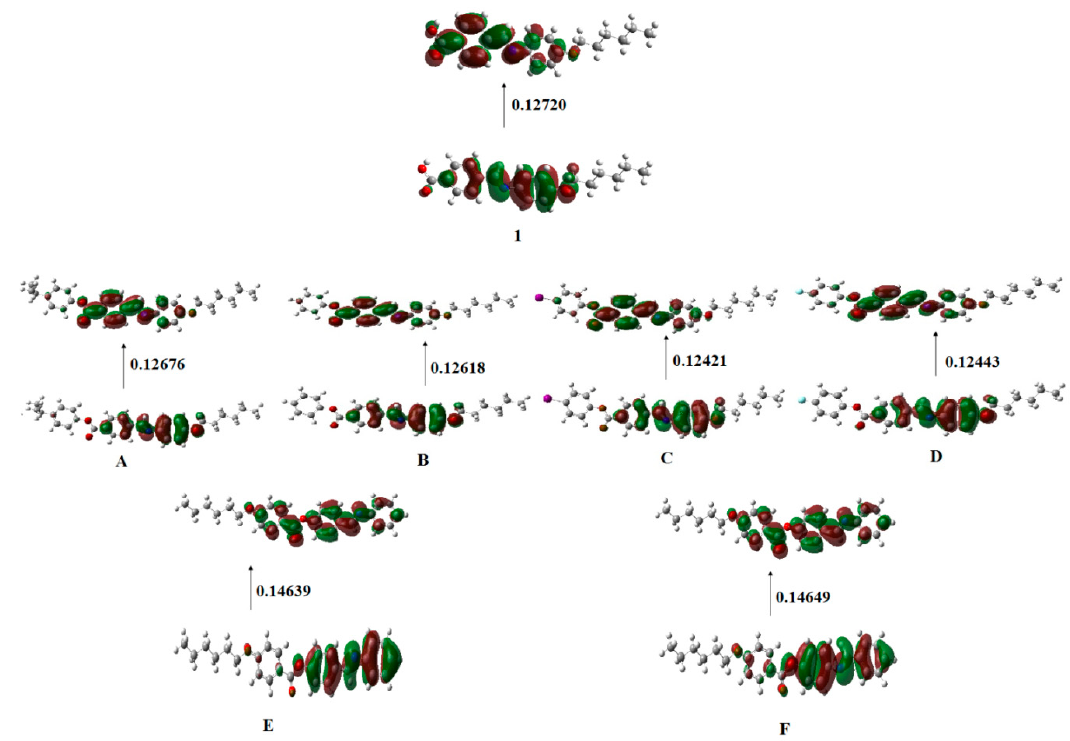
Figure 9. The calculated ground state isodensity surface plots for frontier molecular orbitals of compounds 1 and A – F .